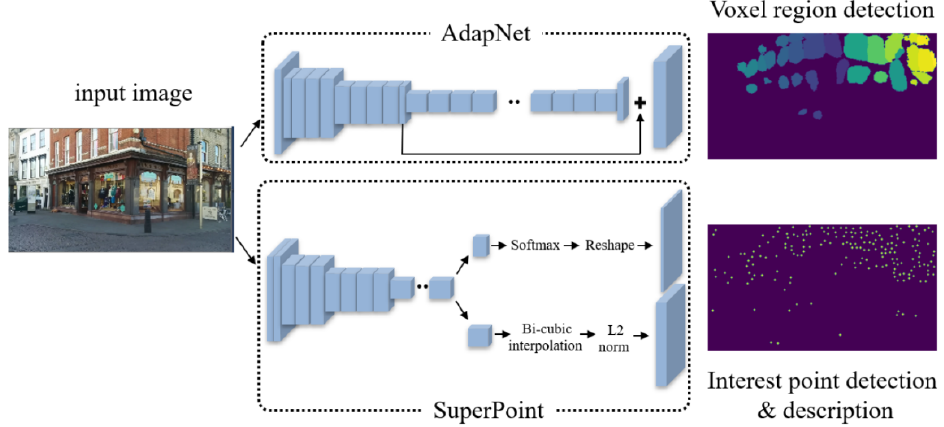
Figure 4. Illustration of the deep learning network architecture used in this study. Separate convolutional neural networks were used for voxel region detection and interest point detection/description.